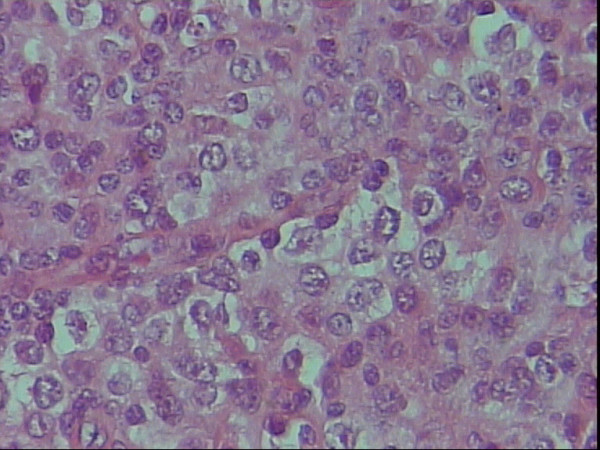
Centroblastic polymorph variant on H&E staining, × 40.